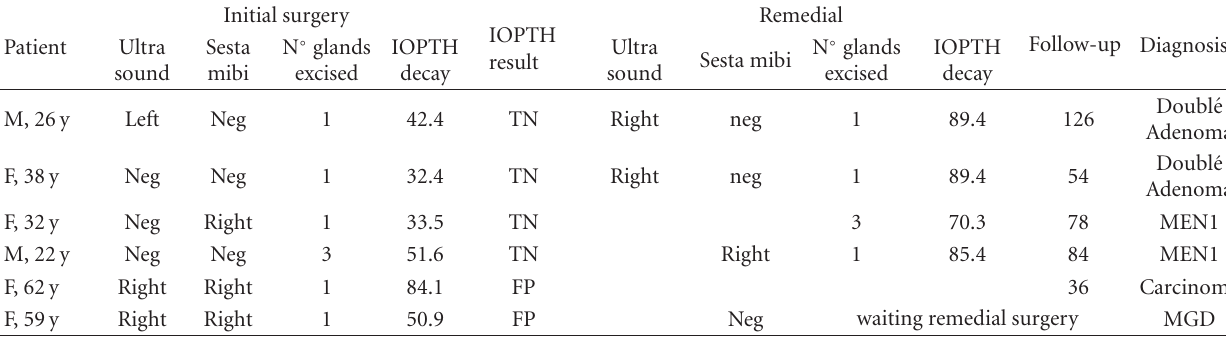
Table 5: Cases of operative